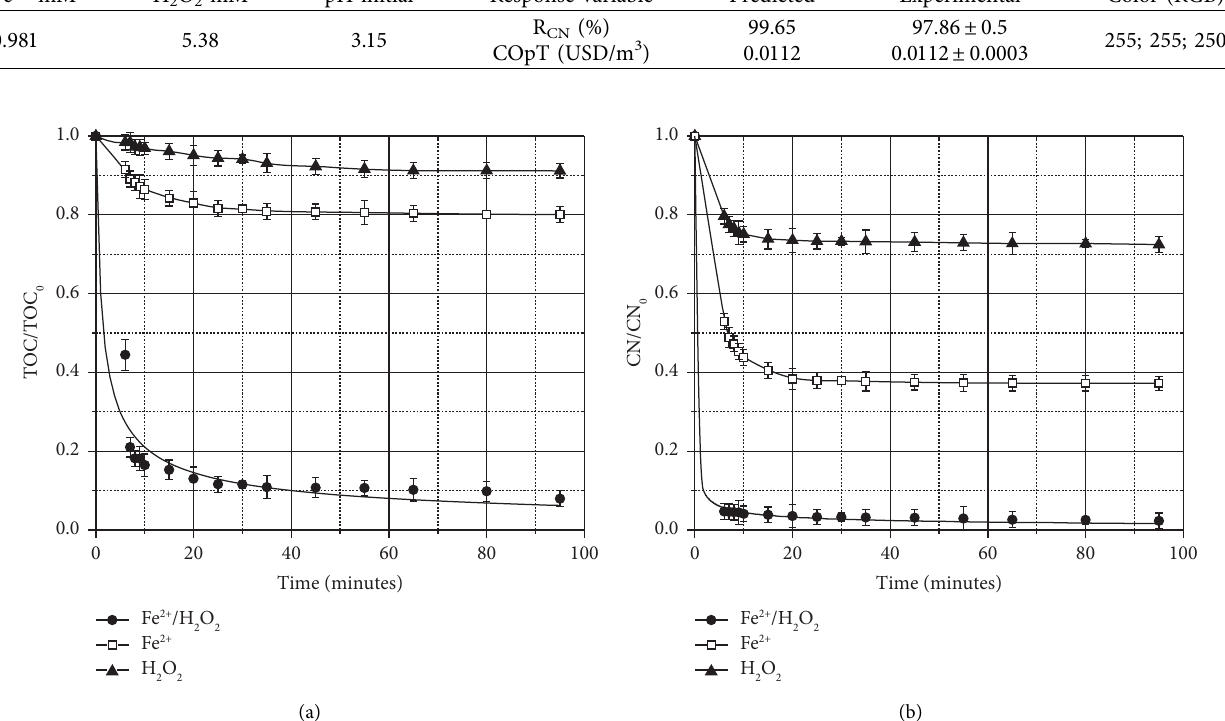
Figure 6: Te evolution of (a) color (CN) removal and (b) TOC removal as a function of reaction time. Fenton operating conditions: initial pH � 3.15, [H 2 O 2 ] � 5.38mM, and [Fe 2+ ] � 0.981mM. Te efciency of Fe 2+ alone ([Fe 2+ ] � 0.981 mM) and H 2 O 2 alone ([H 2 O 2 ] � 5.38mM) at pH � 3.15 is also included.